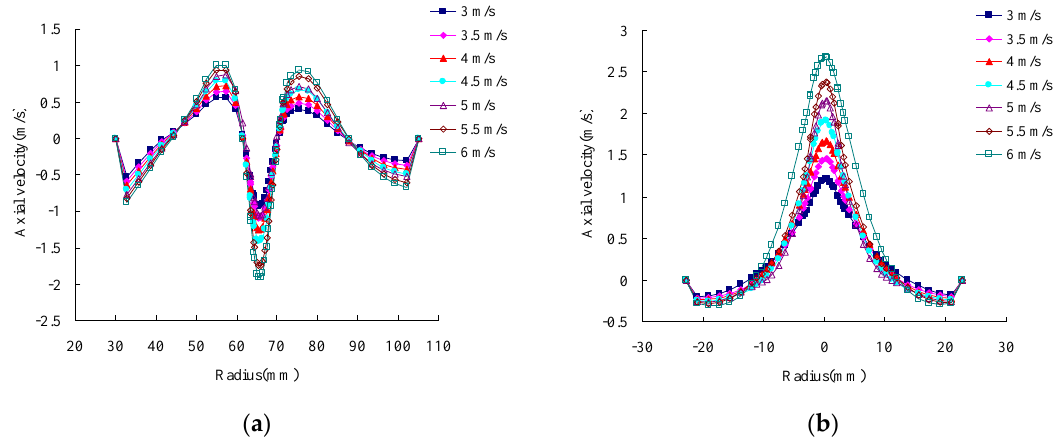
Figure 8. Axial velocity profiles: ( a ) Z = 300 mm (first stage); ( b ) Z = 150 mm (second stage).